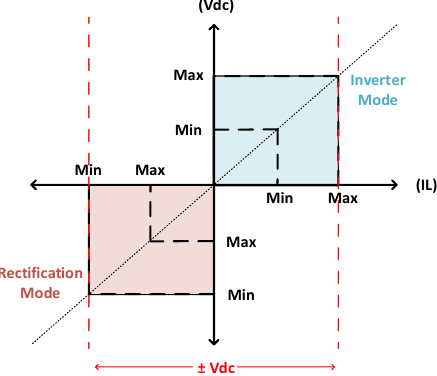
Figure 15. The regulation technique of DC-bus voltage (Vdc) with associated linearity of relationship with the inductor current (IL). A comparison summary of the implemented control is presented in Table 4. Table 4. Summary of control implementation of transformer and transformerless bidirectional to- pologies for DC distribution systems. Ref.